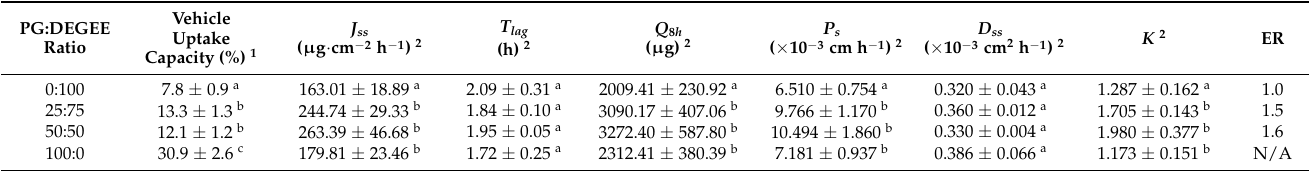
Table 3. Vehicle uptake capacity of mucosa and ex vivo permeation parameters of CBD with PG: DEGEE binary